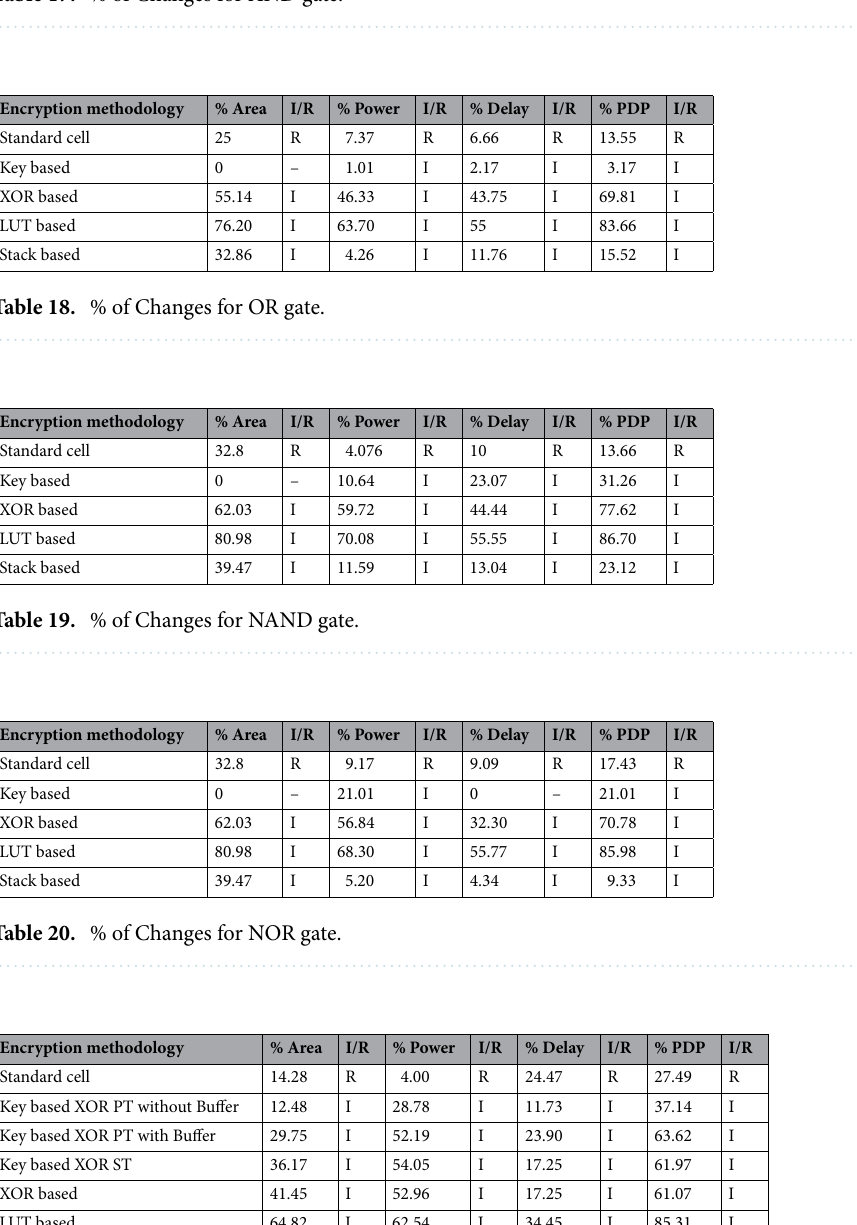
Table 17. % of Changes for AND gate.